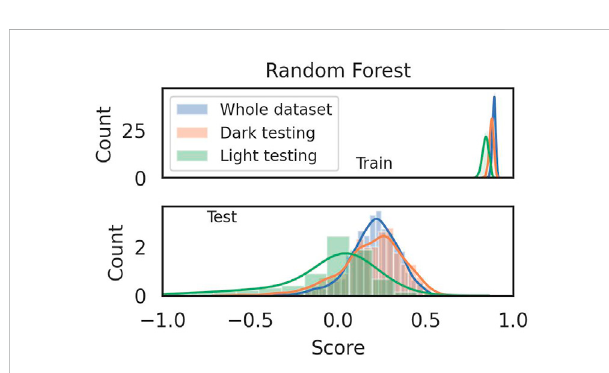
FIGURE 7 Train and test score for Random Forest. The train score is good, while the test score shows high variability, being acceptable most of the time but falling to negative values